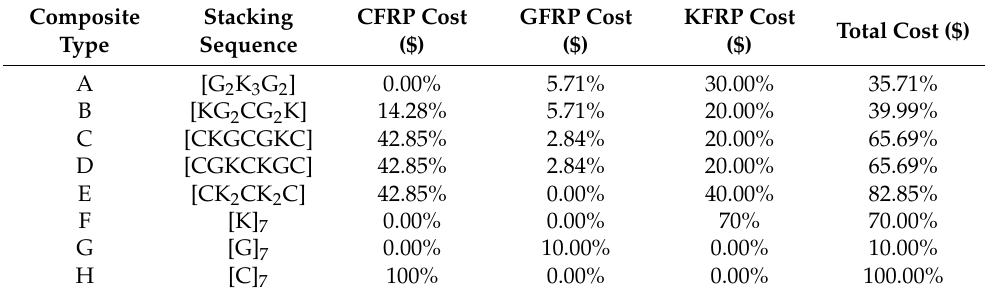
reinforced polymer